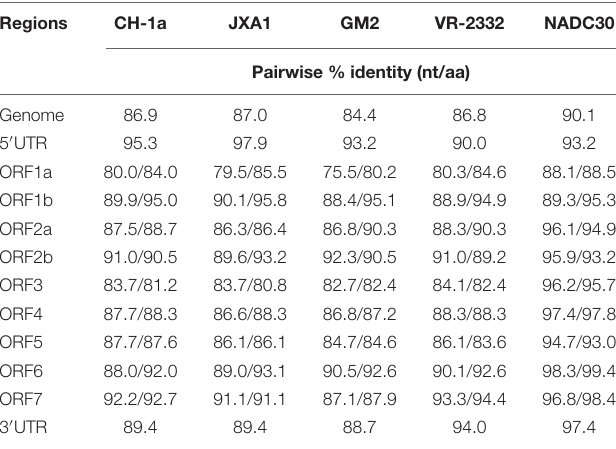
TABLE 3 | Nucleotide and amino acid sequence identity (%) of ZJqz21 as compared to five representative PRRSV strains.